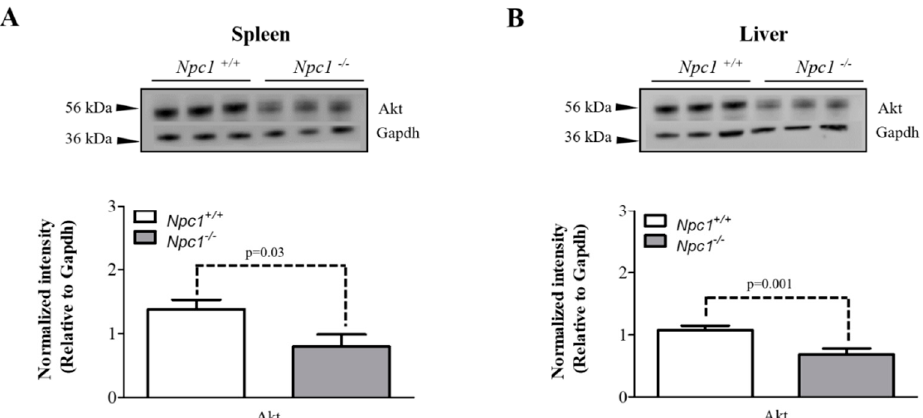
Figure 4. Upstream regulator analysis of the differential proteome of the spleen from 11-week Npc1 − / − mice. Predicted upstream regulator analysis from 11-week Npc1 − / − mice suggest that Tcl1a is a common regulator of various deferential proteins of the spleen. Assignment was based on the Ingenuity Pathway Analysis Knowledge Base Library. GPNMB = Transmembrane glycoprotein NMB, GUSB = Beta-glucuronidase, ITGAM = Integrin alpha-M, MMP9 = Matrix metalloproteinase-9, MPEG1 = Macrophage-expressed gene 1 protein, Ngp = Nucleolar GTP-binding protein 1, SNX6 = Sorting nexin = 6, C1QC = Complement C1q subcomponent subunit C, CELA2A = Chymotrypsin-like elastase family member 2A, CTSD = Cathepsin D and CTSE = Cathepsin E.